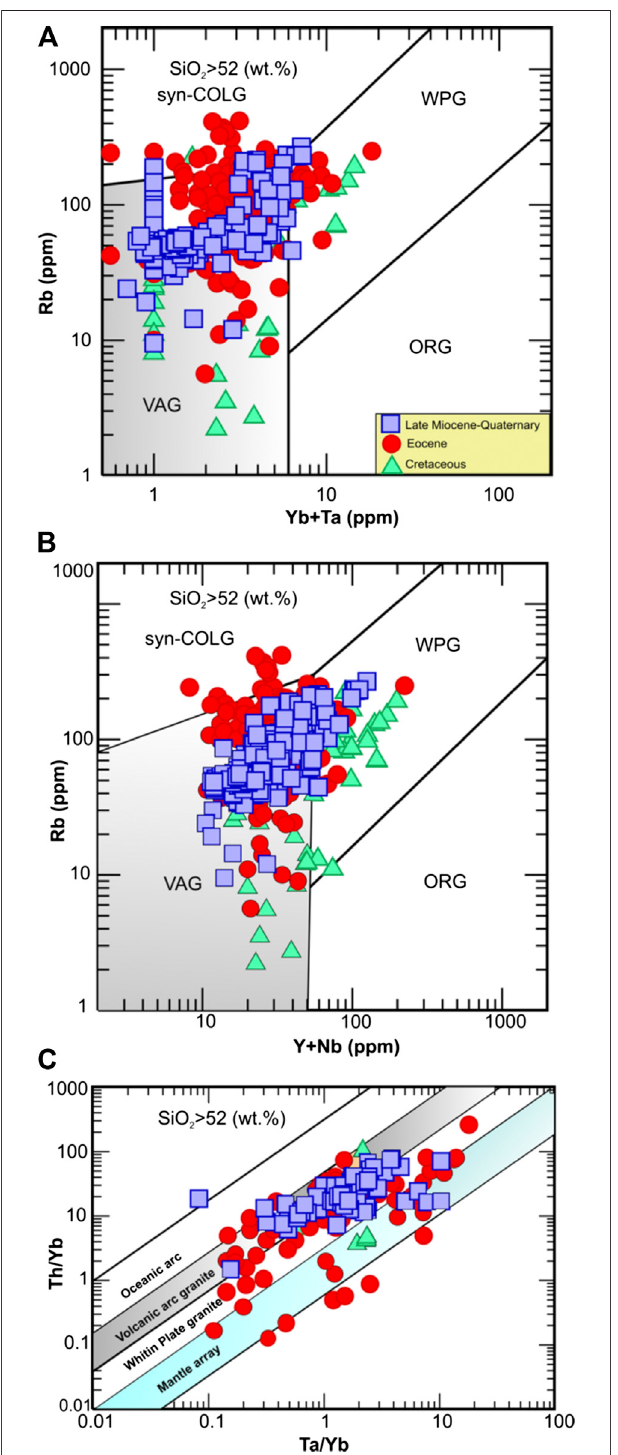
FIGURE 9 | Intermediate to acidic rocks (SiO 2 > 52 wt%) of the Eocene FIGURE 9 | intermediate-to-acidic rocks and more af fi nity of the upper and Miocene mainly plot in the volcanic-arc, tectonic regime, whereas Miocene – Quaternary for the within-plate fi eld (C) . For source data and ref- Cretaceous rocks plot in the arc and within-plate fi elds in the Rb – Yb + Ta (A) erences, see Supplementary S2 . Abbreviations: MORB (cid:1) Mid-Oceanic and Rb – Y + Nb (B) diagrams (Pearce et al., 1984). The variation in the Ridge Basalt; BAB (cid:1) Back Arc Basalt; IAT (cid:1) Island Arc tholeiite; BON (cid:1) Ta/Yb vs. the Th/Yb ratios (Pearce, 1982) shows a wide range for the Eocene Boninite; COLG (cid:1) Collision Granite; VAG (cid:1) Volcanic Arc Granite; ORG (cid:1) ( Continued ) Oceanic Ridge Granite; WPG (cid:1) Within-Plate Granite.